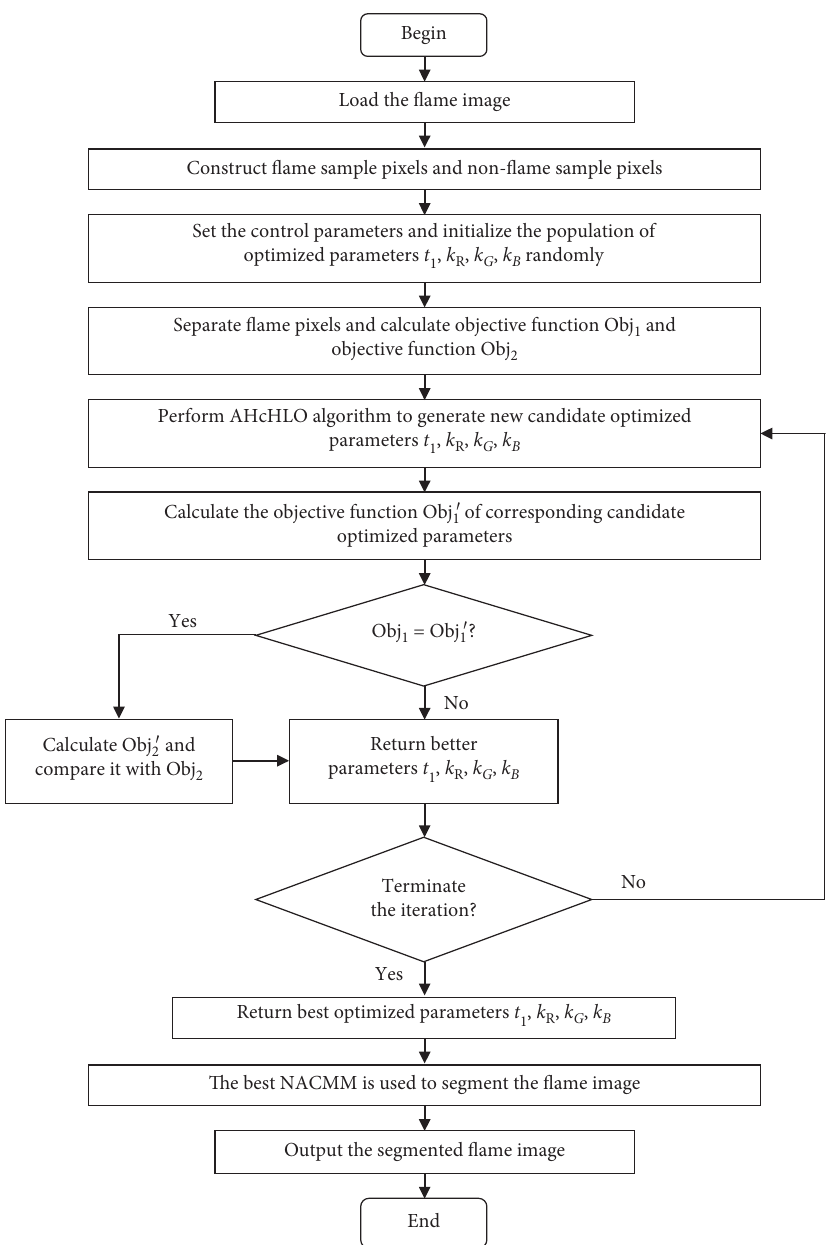
Figure 7: Flowchart of proposed furnace flame segmentation method.